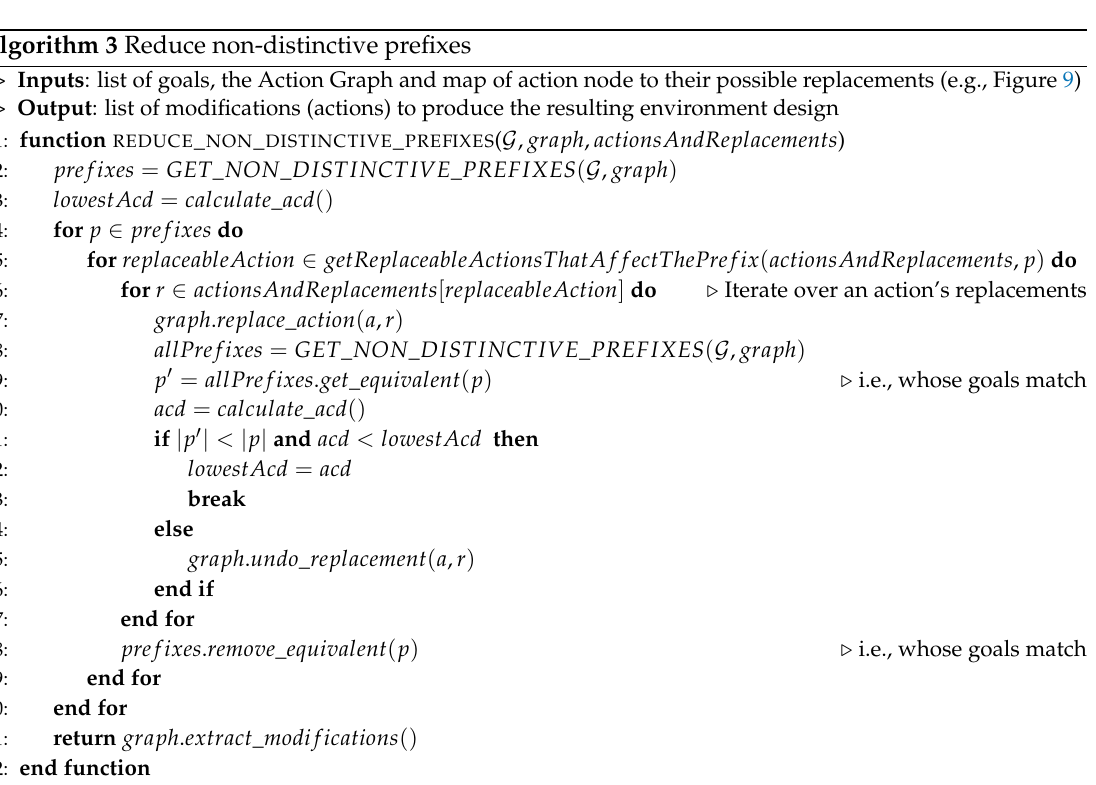
Algorithm 3 Reduce non-distinctive